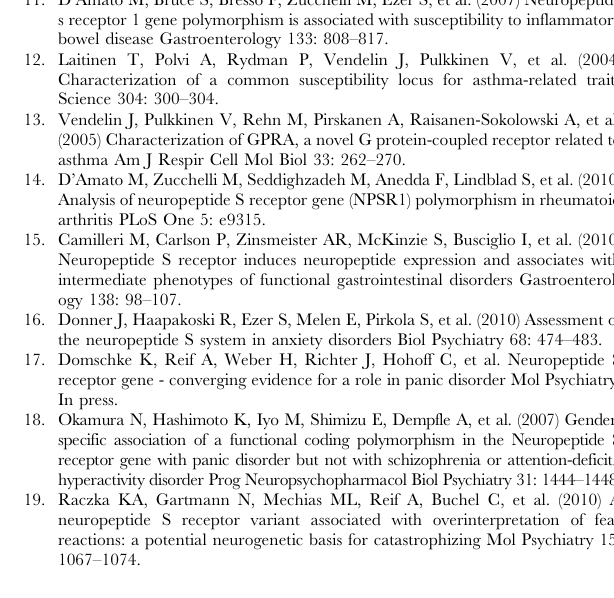
Figure S4 Linkage disequilibrium (LD) structure of the NPSR1 gene region. LD displayed by GOLD heatmap in the NPSR1 gene region (chr7:34662000–34887000), generated with Haploview on genotype data from the CEU (CEPH) population of European descent. NPSR1 exons (vertical blocks) and the functional SNPs identified in our study are reported on top of the LD plot. Table S1 NPS-inducd differential gene expression in cells transfected with the indicated NPSR1 variant vs cells transfected with an empty vector. Genes/probesets with fold change . 2 in at least one transfection are reported (- denotes downregulation). Fold change values , 2 are reported only for comparison, and are highlighted in